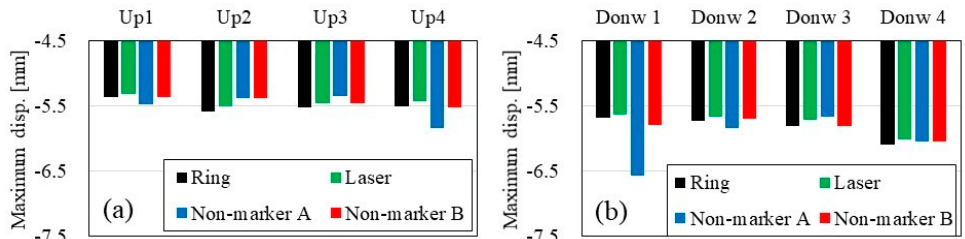
Figure 22. Comparison of maximum displacements of bridge B: ( a ) four up-train passages, ( b ) four down-train passages.